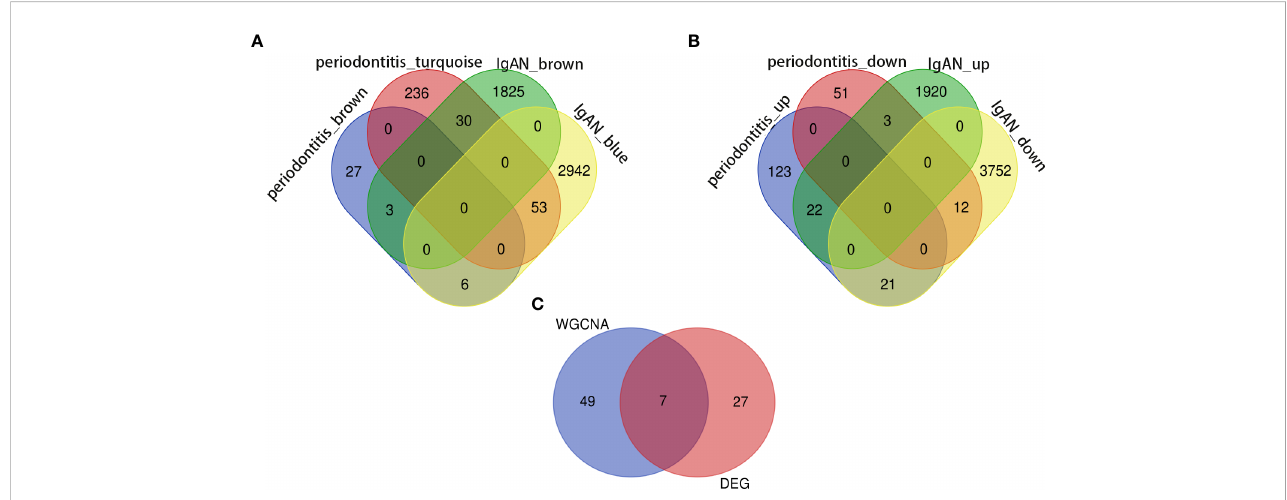
FIGURE 2 Identi fi cation of the shared genes. (A) Venn diagram shows that 56 genes overlap in the IgAN and periodontitis modules. (B) Venn diagram showing an overlap of 34 DEGs between IgAN and periodontitis. (C) Venn diagram showing that seven core genes were crossed and overlapped between the genes screened by WGCNA and DEGs. IgAN: IgA nephropathy; DEG: differentially expressed gene; WGCNA: weighted gene co-expression network